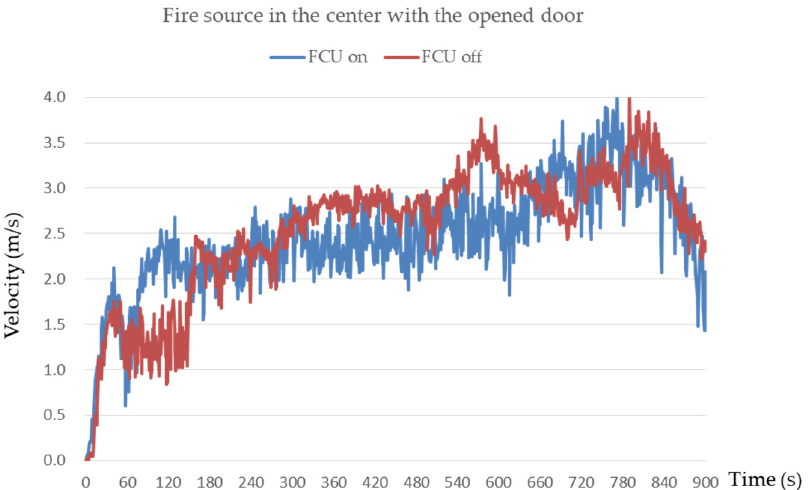
Figure 9. The outward smoke flow velocity at 0.2 m below the door lintel.